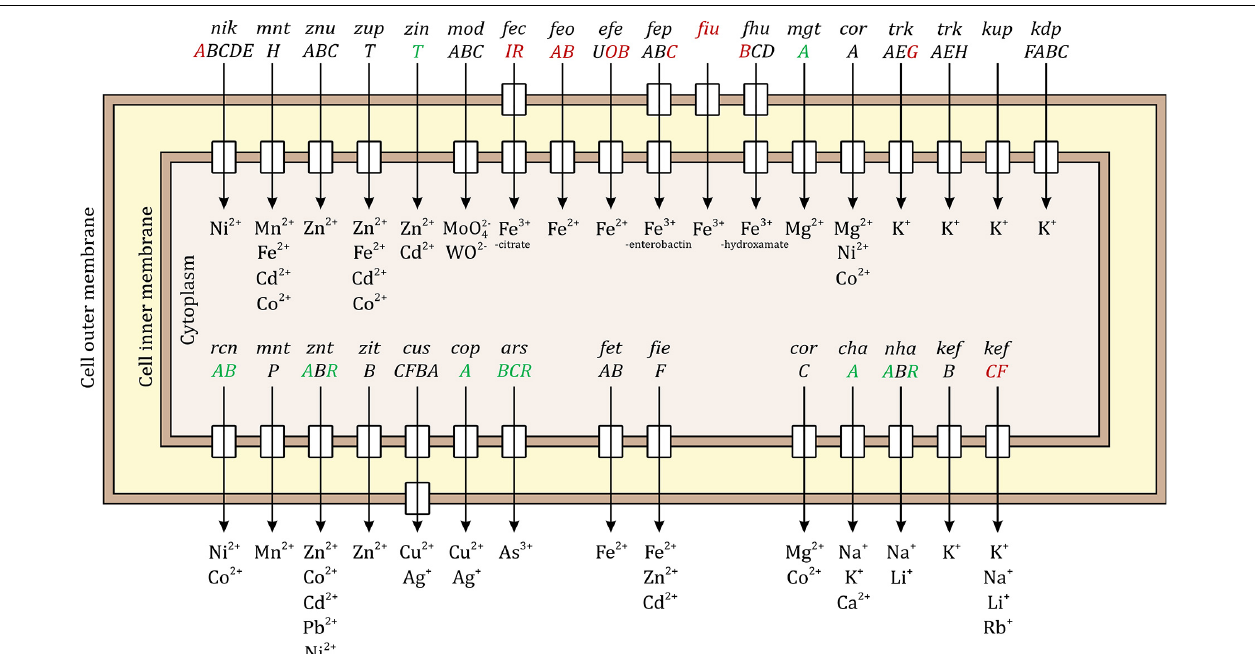
FIGURE 5 | Palladium (Pd) stress effects on inorganic metal ion import and export systems in E. coli . The upper half of the figure shows the systems responsible for ion import and the lower half shows the systems responsible for ion export. Some systems are specific to one metal ion while other can transport a variety of ions. The small rectangles in the inner membrane indicate that the system has an inner member permease protein and the rectangles in the outer membrane indicate that the system includes an outer membrane porin. The up-regulated genes due to Pd stress are shown in green, the down-regulated genes in red, and the unaffected genes in black. Ten of the importing systems were modulated, 8 of them were down-regulated. All the iron importing systems were down-regulated. Seven of the exporting systems were modulated, 6 of them were up-regulated.